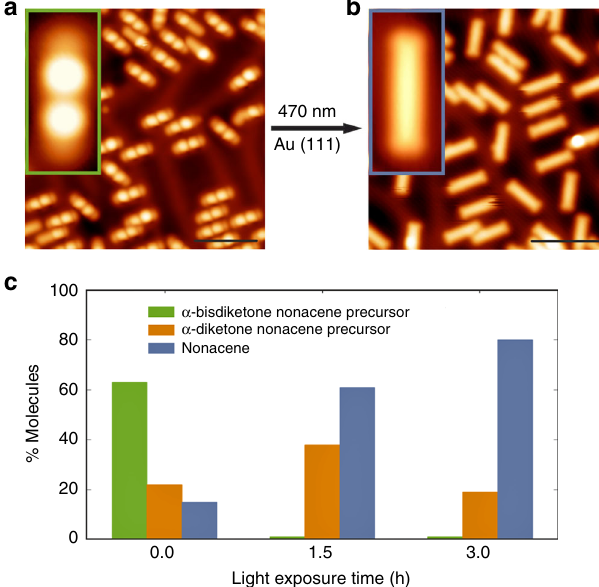
Fig. 2 Nonacene formation via photodissociation of 2 . a STM image after room temperature deposition of the α -bisdiketone nonacene precursor on Au(111) surface. V b = 0.7 V, I = 2 pA. Scale bar: 5 nm. The inset shows a high-resolution STM image of an individual α -bisdiketone nonacene precursor where two bright protrusions of identical apparent height are assigned to the upward-pointing bridged α - diketone groups. Image size 1.5 nm x 3.5 nm, V b = − 1.5 V, I = 4 pA. b STM image of nonacene species after light exposure ( λ = 470 nm, 3 h) of the sample in panel a . V b = − 1 V, I = 7 pA. Scale bar: 5 nm. The inset shows a high-resolution STM image of an individual nonacene. Image size 1.4 nm × 3.4 nm, V b = − 1 V, I = 5 pA. c Graph depicting the percentage of photoconverted molecules vs. light exposure time. Statistics out of ~1100 molecules